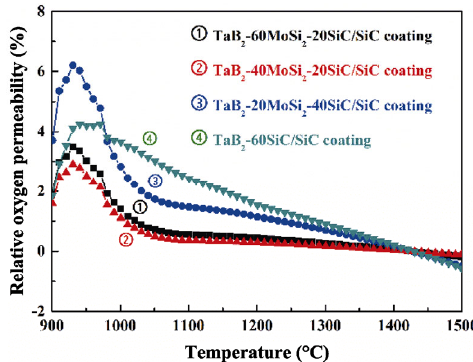
Fig. 13 Relative oxygen permeability curves of the fabricated different